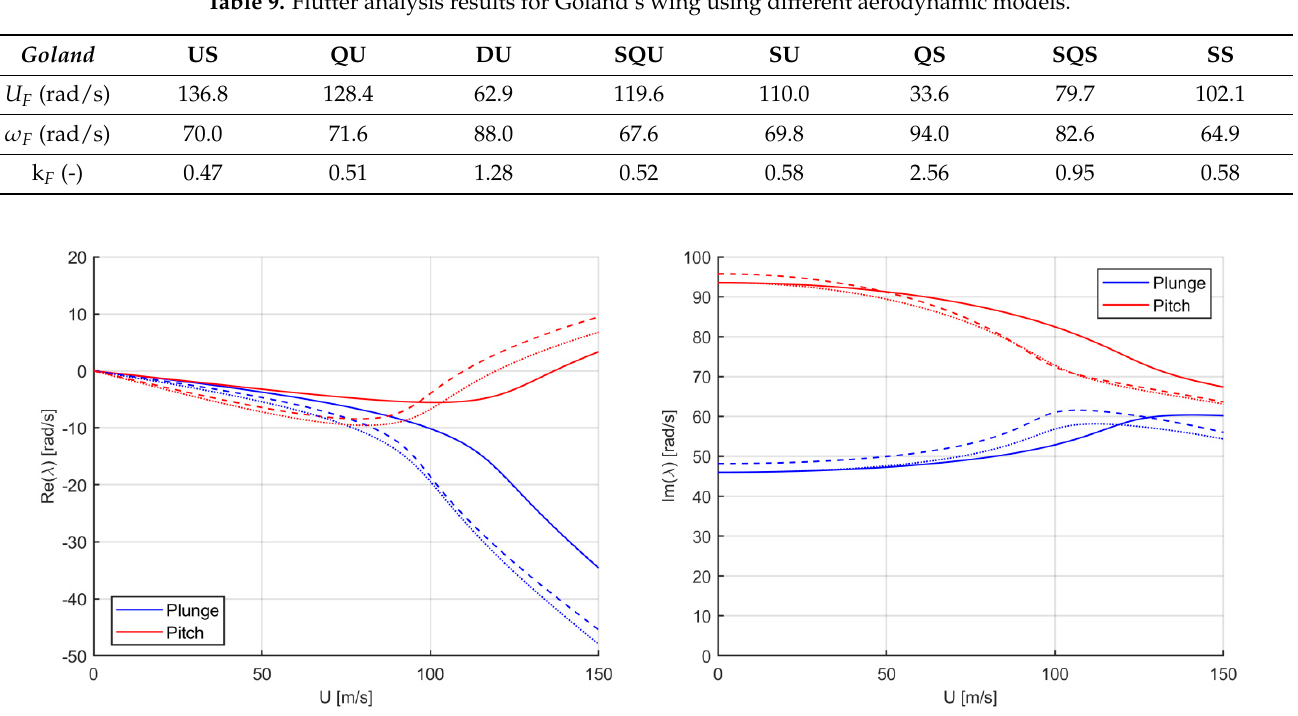
Figure 10. Evolution of the complex eigenvalues for Goland’s wing: real part ( left ), imaginary part ( right ); continuous, dashed and dotted lines for QU, QS and SQS aerodynamic models, respectively.